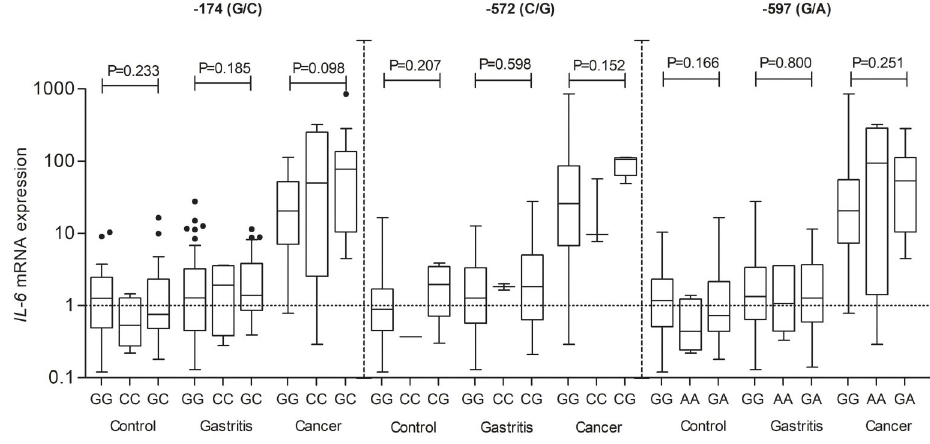
Figure 3. Analysis of interleukin-6 ( IL-6 ) gene expression and rs1800795, rs1800796, and rs1800797 polymorphisms (percent of Control) in Control, Gastritis, and Cancer groups. Data are reported as medians and interquartile range